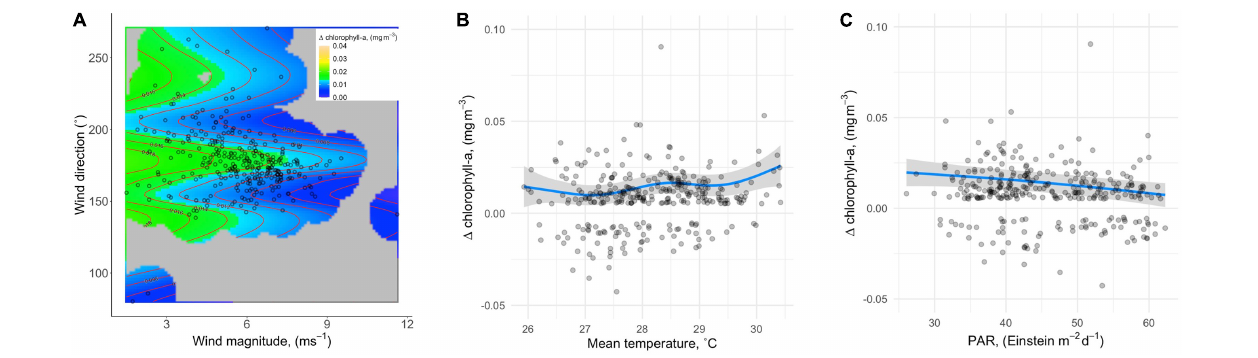
FIGURE 3 | Effect plots from Model 1 in Table 2 , which had the highest weight (0.337) relative to other best-specified models (A) IME magnitude as a function of wind. (B) IME magnitude as a function of SST. (C) IME magnitude as a function of PAR. As all modeled effects have the prediction estimate above the 0 (cid:49) chl line on the y -axis, they are describing effects on the magnitude of IME for